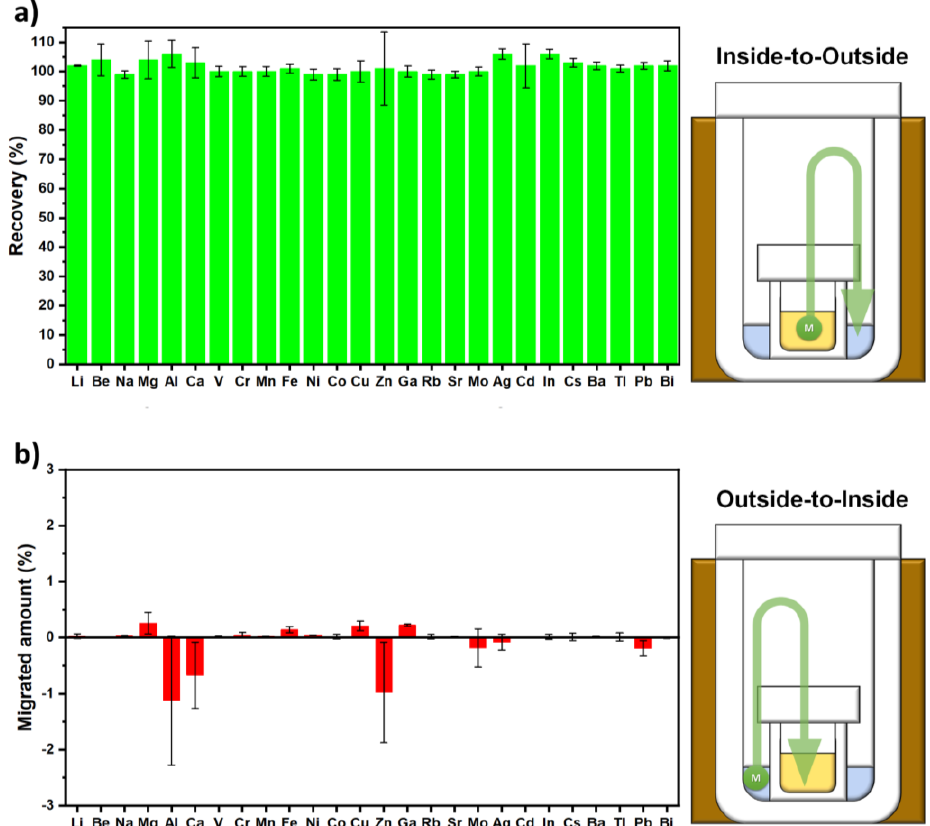
Figure 4. Recoveries obtained for 27 selected trace elements when analyzing the digestion solution after cross-contamination experiments: ( a ) Inside-to-Outside migration test and ( b ) Outside-to-Inside migration test.